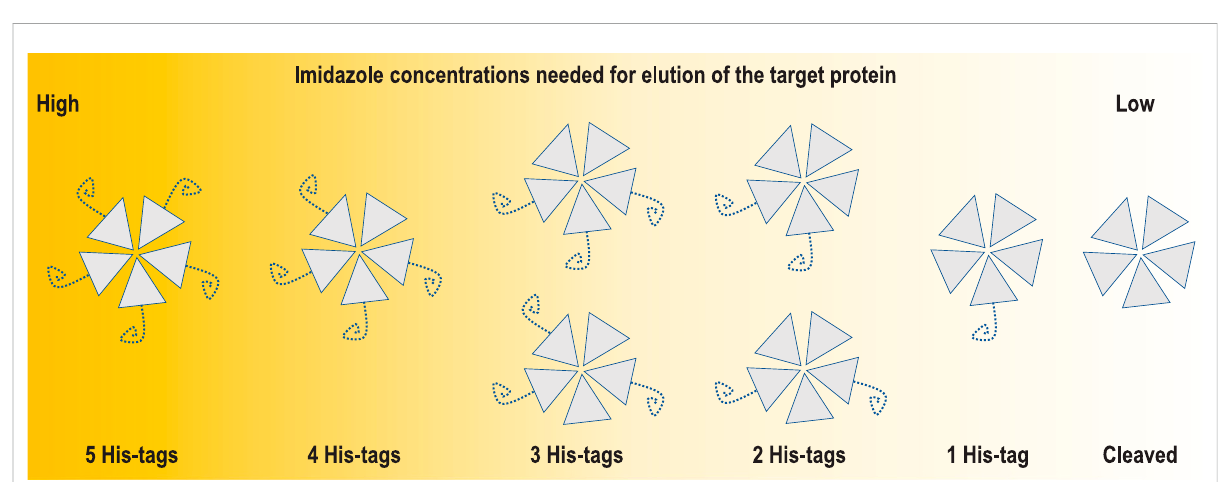
FIGURE 7 Schematic representation of an incomplete cleavage problem for a pentameric protein such as coproheme decarboxylase. The incomplete cleavage may make partially labelled particles escape binding to the af fi nity column and fl ow through together with oligomers having all His-tags cleaved. This is why for multimeric proteins, it is worth performing detailed analysis of the applicable ranges of eluting agent